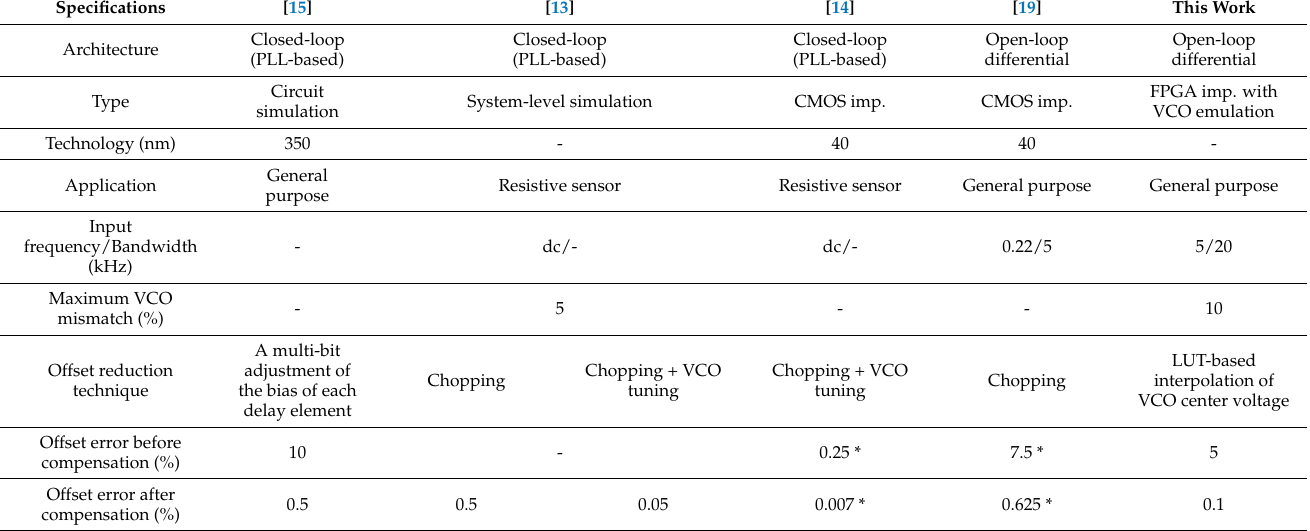
Table 2. Comparison with prior works.